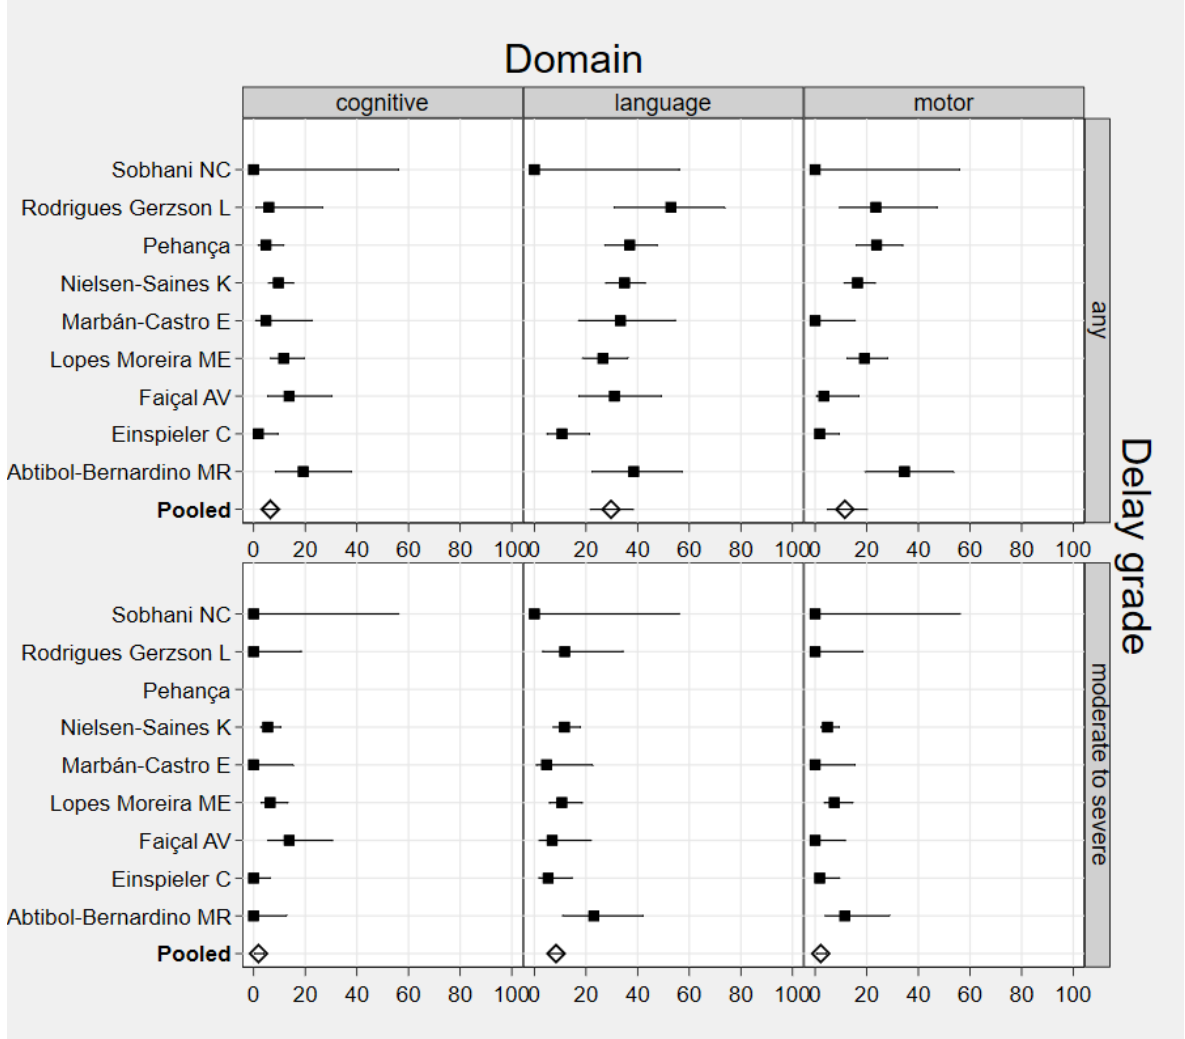
Figure 2. Forest plot of the prevalence of neurodevelopmental delays in children with prenatal ZIKV exposure and study authors. I²: variation in prevalence attributable to heterogeneit.; Cognitive domain: Differences between publications are low (I 2 = 47.8%); thus, fixed-effects pooled prevalence was considered. Language domain: Differences between publications are low (I 2 = 0.0%); thus, fixed-